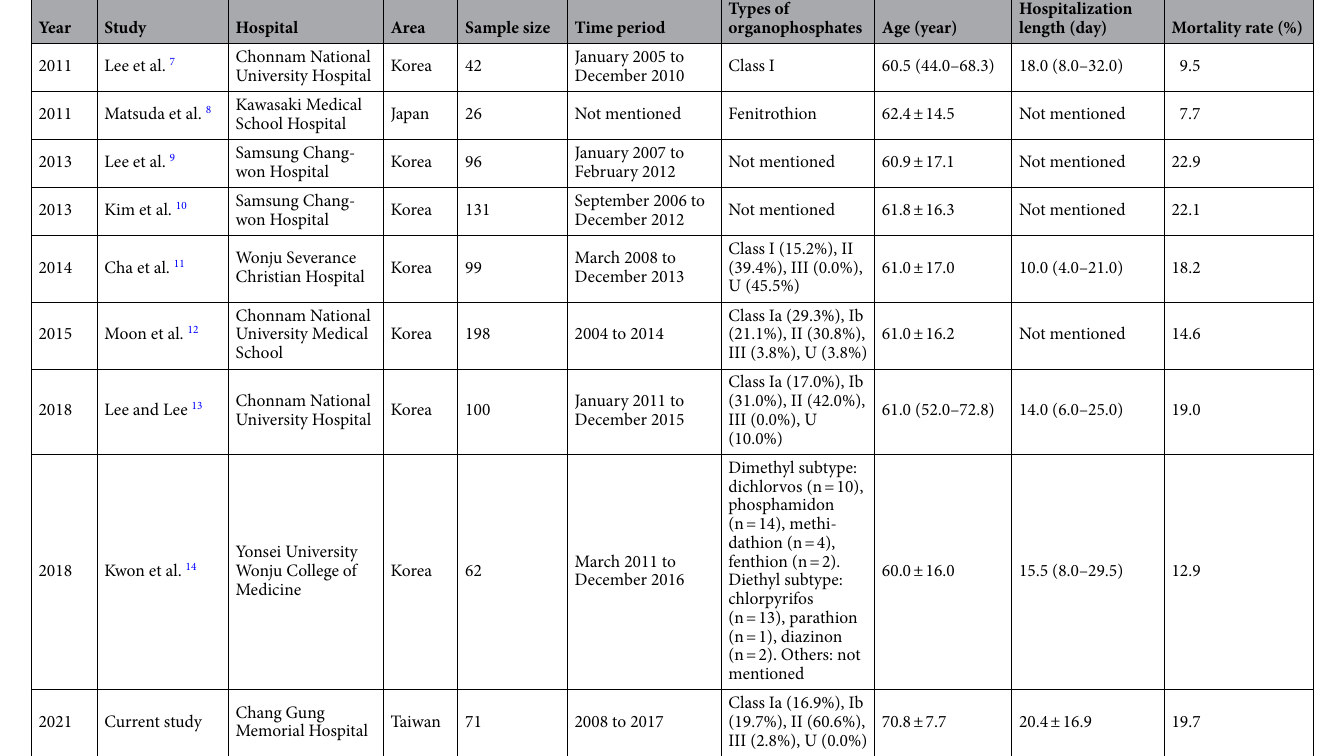
Table 1. Study of organophosphate intoxication in elderly patients (sample size more than 5). Age and hospitalization length are presented as the mean ± standard deviation or median with interquartile range. Pesticide toxicity was categorized as follows, according to World Health Organization recommendations: Ia extremely hazardous, Ib highly hazardous, II moderately hazardous, III slightly hazardous and U unlikely to present acute hazards 42